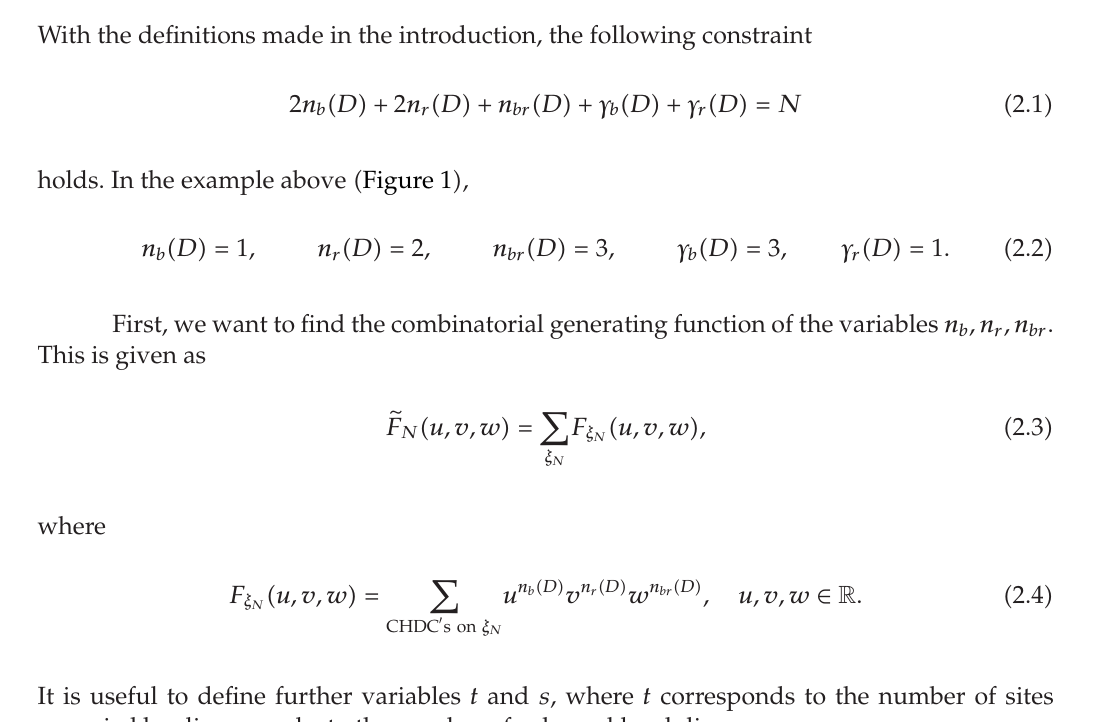
Figure 1: A CHDC (cid:2) N (cid:8) 13 (cid:3) with two red dimers and one blue